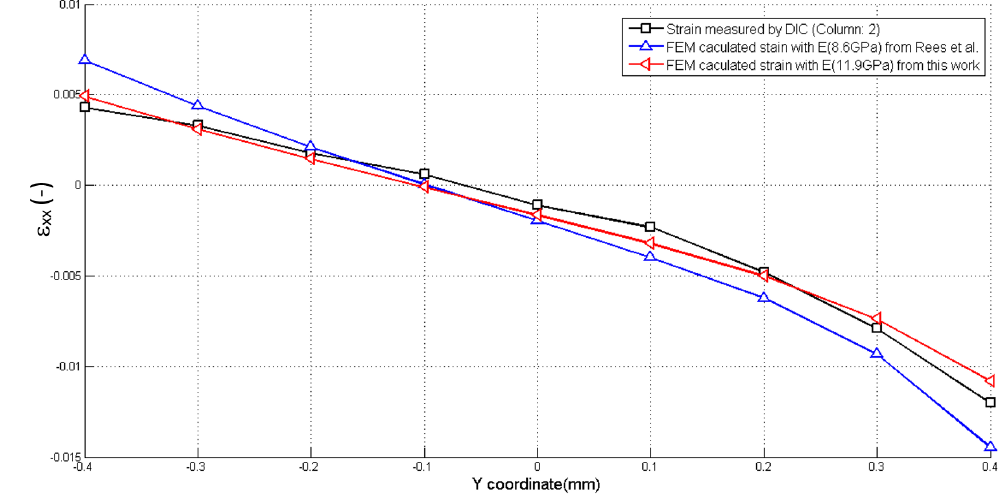
Figure 11. The comparison of ε